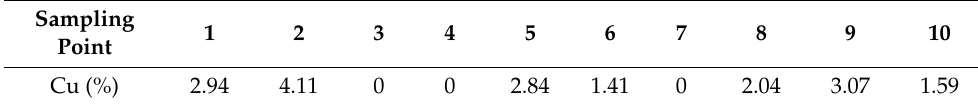
Table 3. Relative percentage of Cu at each point in Figure